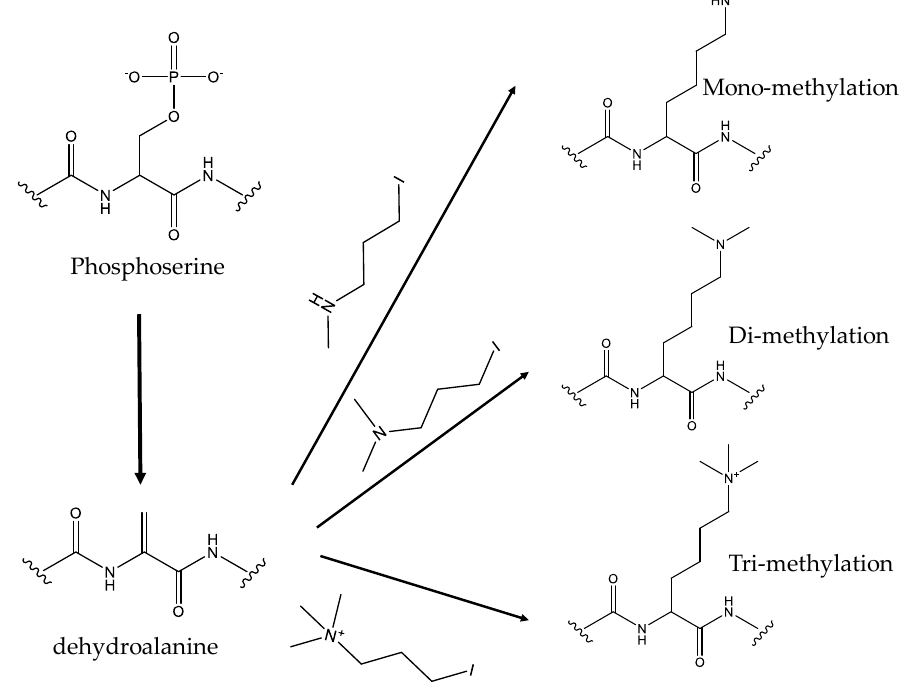
Figure 4. The schemes for producing methylated proteins. Phosphoserine is first site-specifically incorporated into proteins and dephosphorylated to form dehydroalanine, then formed different methylated proteins with different alkyl iodides.